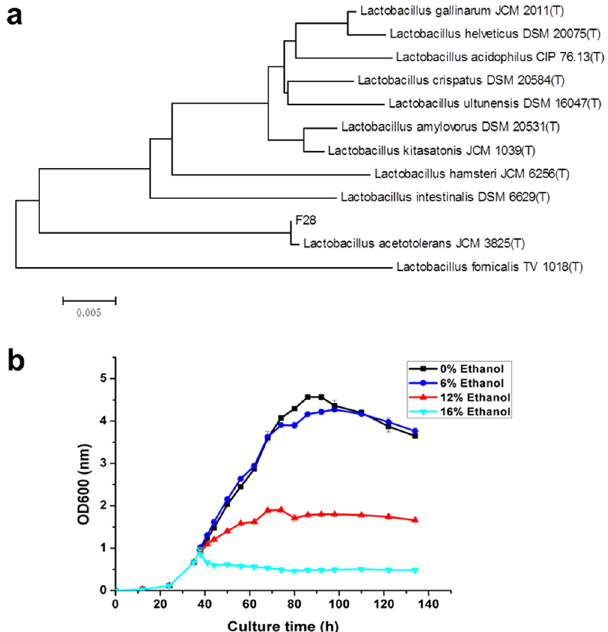
Figure 1. Identification and growth curve of L. acetotolerans F28. ( a ) Phylogenetic tree based on 16 S rRNA gene sequence comparisons showing the position of strain F28 and related species of the genus Lactobacillus . ( b ) Growth curve of in MRS5 medium in the presence of various concentrations (v/v) of ethanol. Ethanol was added when OD 600 =